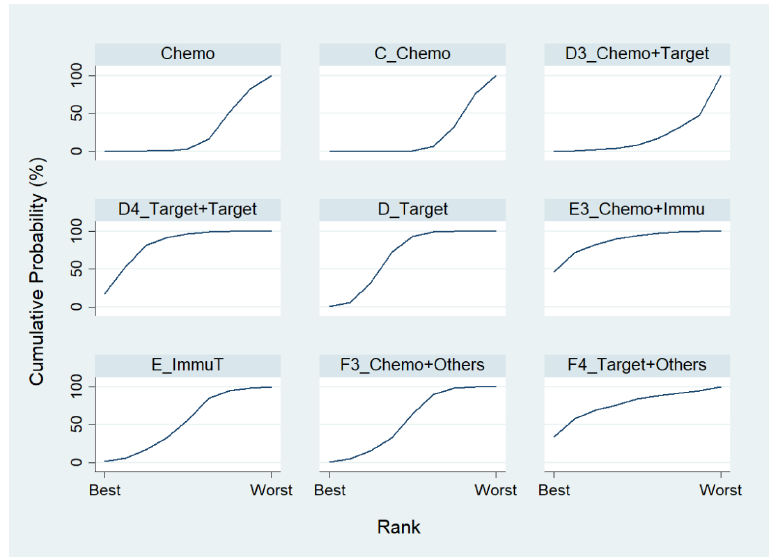
Figure 4. Rankogram for the advanced lung cancer in response rate.